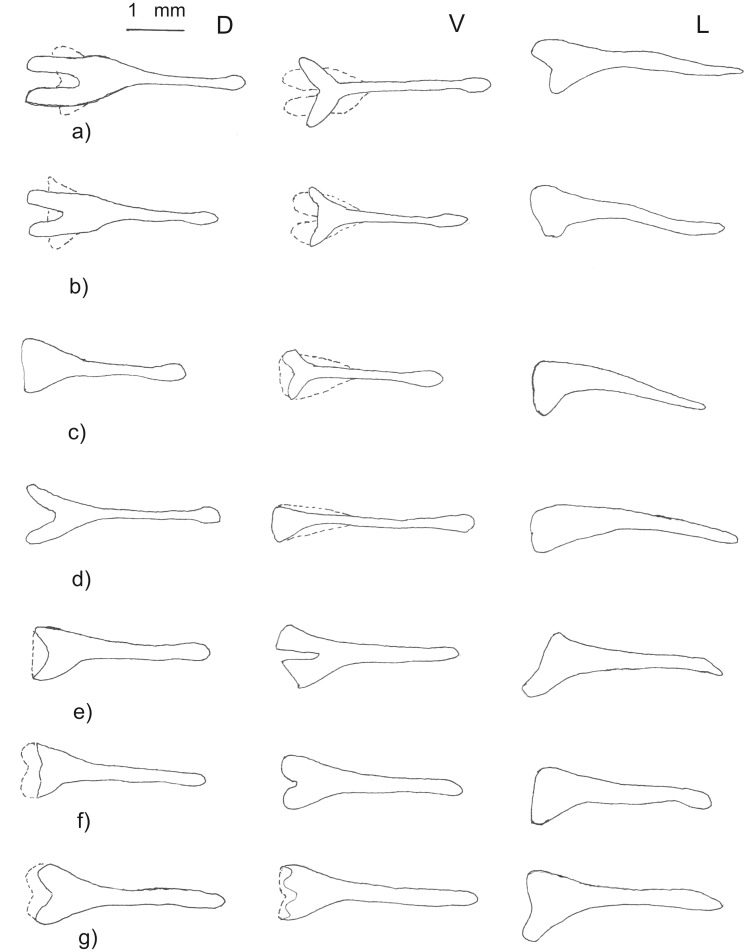
Dorsal (D), ventral (V) and lateral (L) view of bacula (tips on right) from four individuals (a–d) from Mpumalanga (Clade 1a = cohenae sp. nov.), two (e–f) from lowland sites in Mozambique (Clade 2 = mossambicus sp. nov.) and one (g) from Mt Mabu in Mozambique (Clade 1b = mabuensis sp. nov.). a = DM 11558 (Sudwala); b = DM 11620 (Barberton Tunnel; Topotype of cohenae); c = DM 11560 (Mayo); d = DM 11618 (Barberton Tunnel); e = DM 8580 (Gorongosa); f = DM 8578 (Niassa GR; Holotype of mossambicus); g = DM 10842 (Mt Mabu; Holotype of mabuensis).Bacula of Clade 1a (cohenae sp. nov.) have spatulate tip (rounded in Clades 2 (mossambicus sp. nov.) and 1b (mabuensis sp. nov.)), typically emarginated basal portion (less so in Clades 2 and 1b) and shaft laterally compressed (cylindrical in Clades 2 and 1b) and sloping downwards in lateral view (horizontal in Clades 2 and 1b).